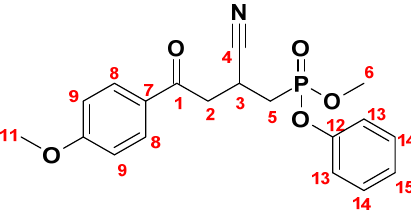
Figure 12. The structure of compound 5l .